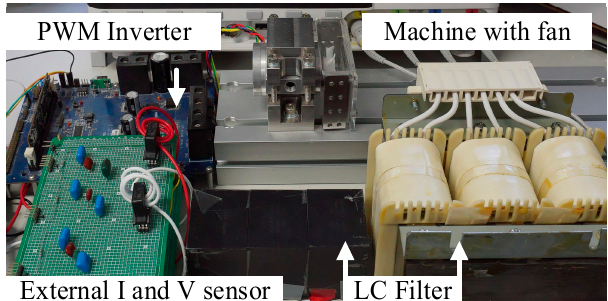
Figure 8. Test setup of PM motor drive with LC filter.